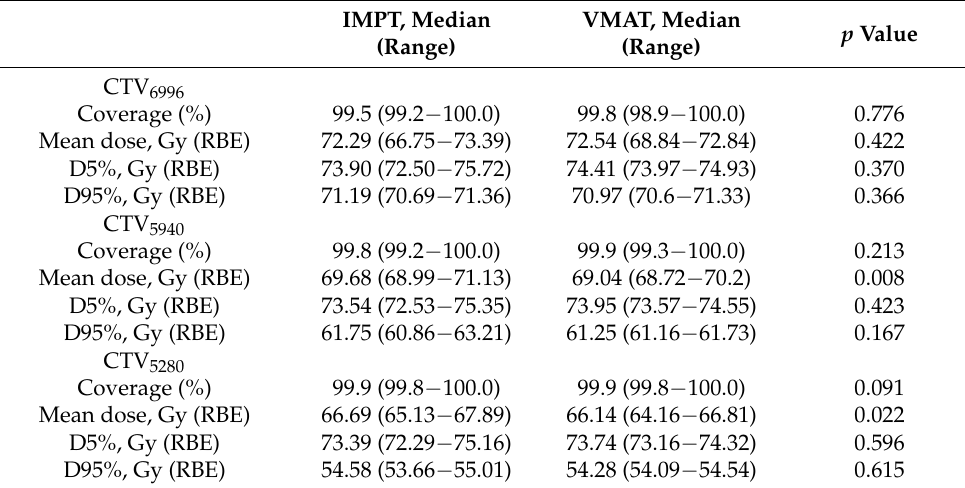
Table 3. Summary of differences in doses to clinical target volumes between intensity modulated proton therapy and volumetric modulated arc